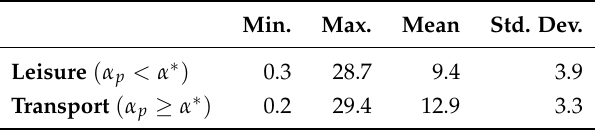
Table 3. Speed Statistics